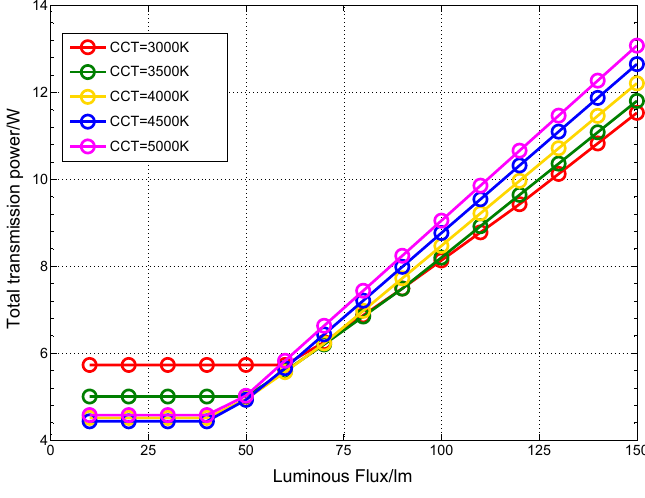
Figure 7. Total transmission power for different CCT values at crosstalk coefficients (cid:101) =